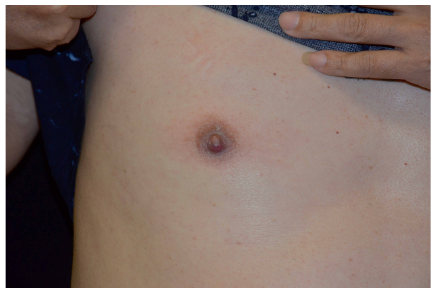
Figure 1: An erythematous erosion with a few exudation on the right nipple before treatment.